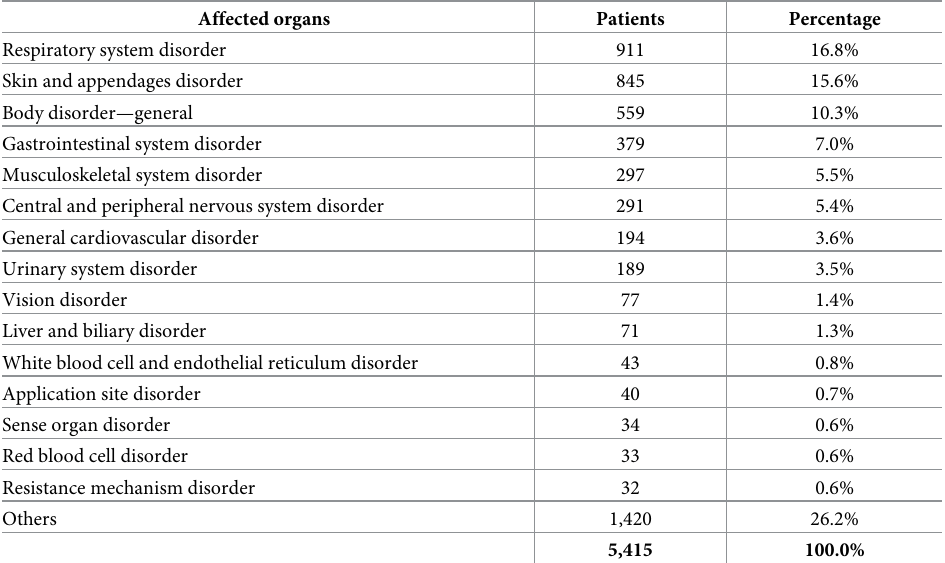
Table 3. Main systems affected by adverse drug reactions to biological agents in Colombia from 2014–2019.